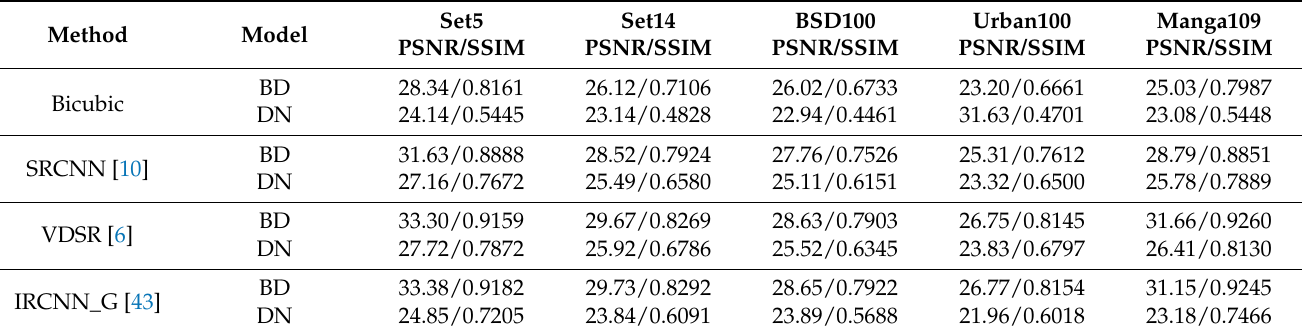
Table 7. Quantitative evaluation results in BD × 3 and DN × 3: Red indicates optimal PSNR/SSIM, and blue is the next best.